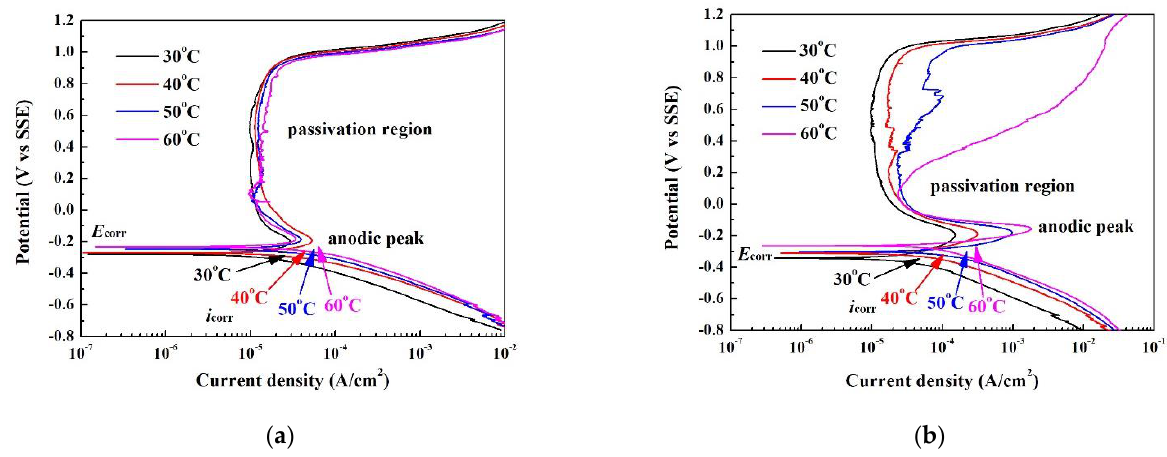
Figure 5. Polarization curves of the Cr 27 Fe 24 Co 18 Ni 26 Nb 5 alloy tested in ( a ) deaerated 1 N H 2 SO 4 solution; and ( b ) deaerated 1 N HCl solution under different temperatures.